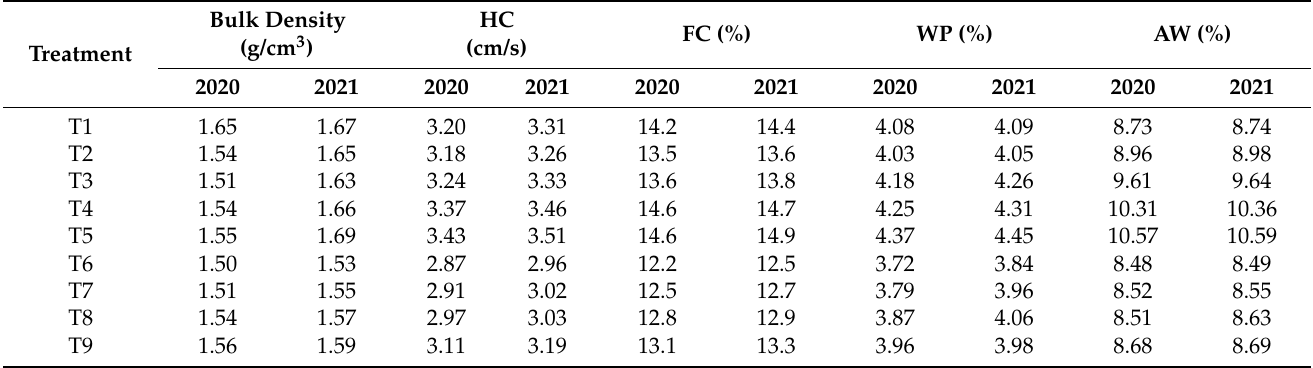
Table 8. Effect of mineral fertilizer alone or combined with superabsorbent polymers (SAPs) on some physical properties of the experimental soil in 2020 and 2021